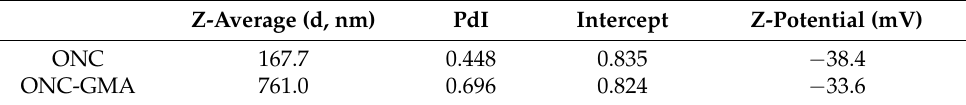
Figure 6. DLS size analysis of ( a ) synthesized ONC and ( b ) synthesized ONC-GMA. Table 2. DLS results for ONC and